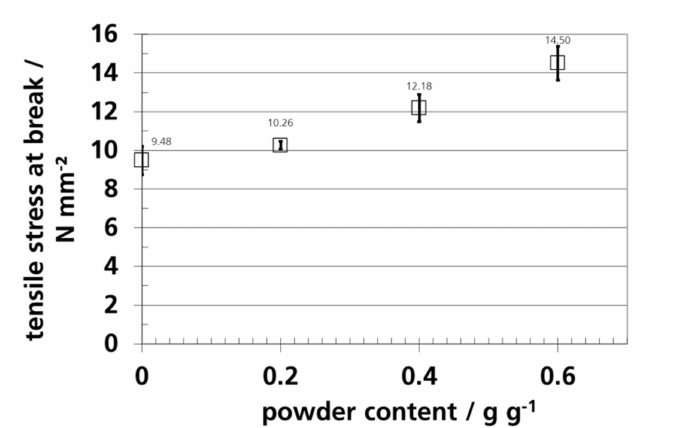
Figure 11. Tensile stress at break of PE-LD films with di ff erent amounts of silica gel